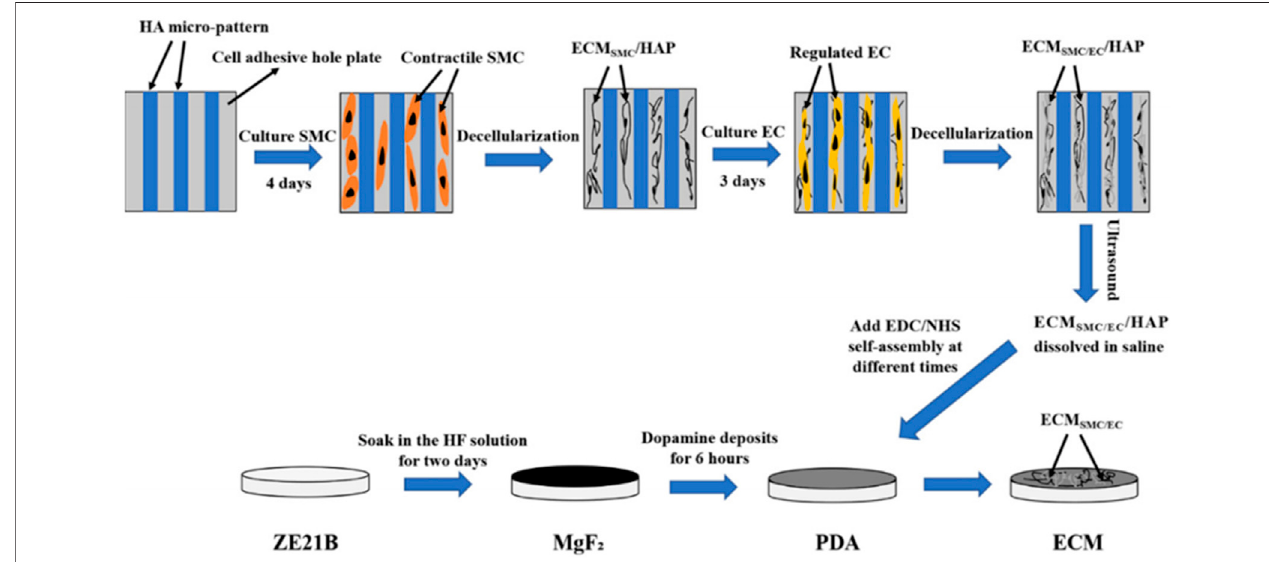
FIGURE 6 | Fabrication of the biomimetic vascular basement membrane with the ECM secreted from the SMC and EC controlled by HA micro-patterned on the non-biodegradable and biodegradable material surfaces (Liu et al., 2022).